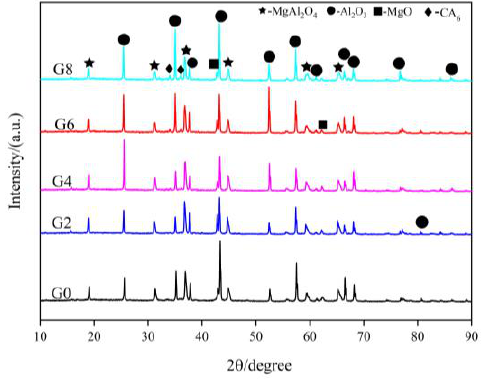
Figure 1. XRD patterns of dry ramming mixes with the addition of CMA after sintering at 1600 °C for 3 h.